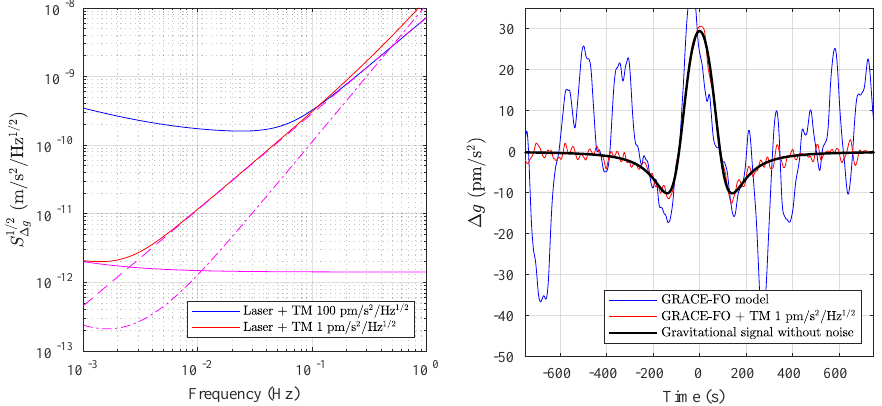
Figure 1. ( Left ) Differential acceleration sensitivity of a two SC geodesy measurement, considering simplified models for GRACE-FO laser frequency and TM acceleration noise (blue) and, in red, the expected performance with GRACE-FO interferometry coupled with the improved GRS TM system studied here, including noise in the GRS TM acceleration and readout. Contributions of TM stray accelerations (solid), laser frequency noise (dashed), and the local TM readout (dash-dot) are shown in magenta. Some drag-compensation is assumed both in order to achieve the acceleration noise requirement and to limit stiffness coupling to GRS readout noise, both relevant only near the 1 mHz lower frequency limit (this includes applied TM forces in the ± 50 pm/s 2 range, with associated stiffness ω 2 xx ≈ 1.25 × 10 − 4 /s 2 ). ( Right ) Simplified simulated differential acceleration signal and noise from a “mascon” with a 1 mm layer of water spread over a 400 km diameter circle in the two configurations (for visualization a 4th order low pass filter with 15 mHz corner frequency is applied to signal and noise in both